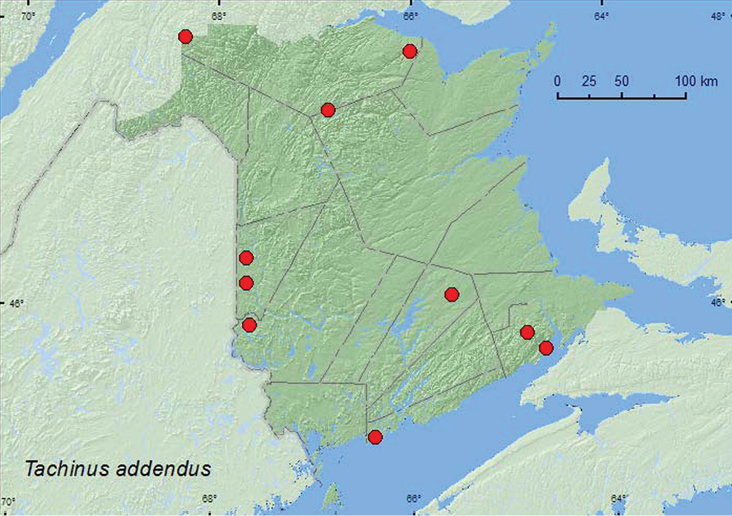
Collection localities in New Brunswick, Canada of Tachinus addendus.